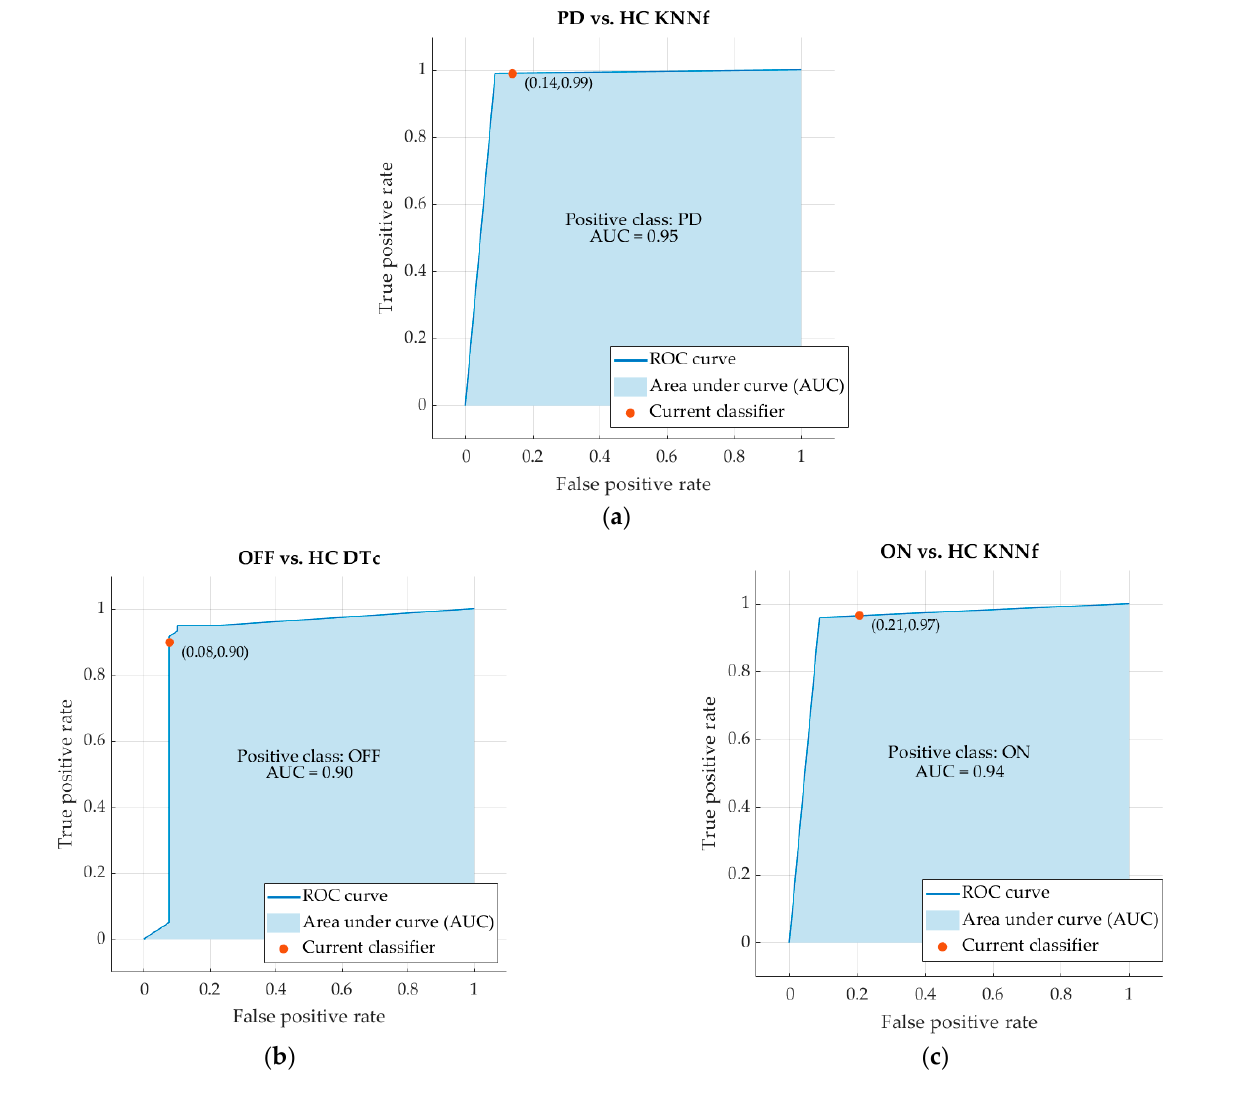
Figure 4. ROC curves and AUC values of the classifiers PD vs. HC ( a ), OFF vs. HC ( b ) and ON vs. HC ( c ).